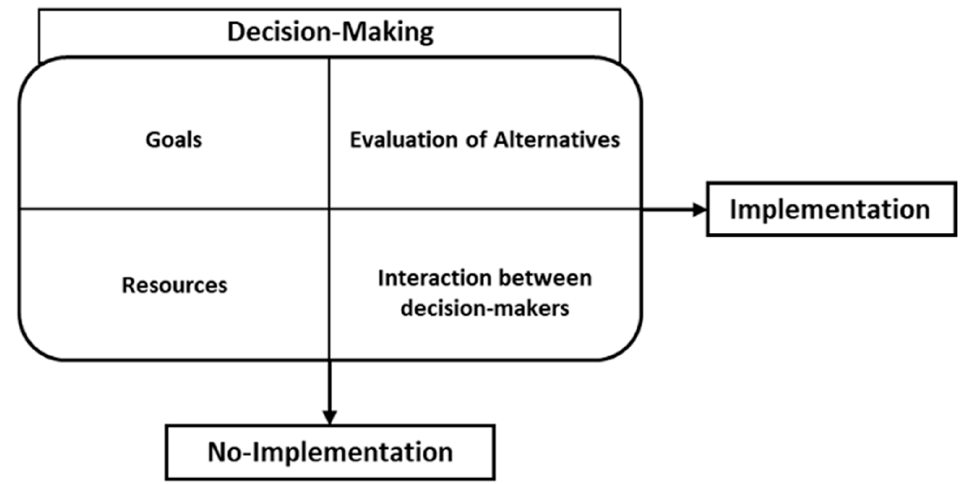
Figure 3. Visual representation of the operation of the Muddling Through Framework. Source: the authors (based on Lindblom, 1959–1979).